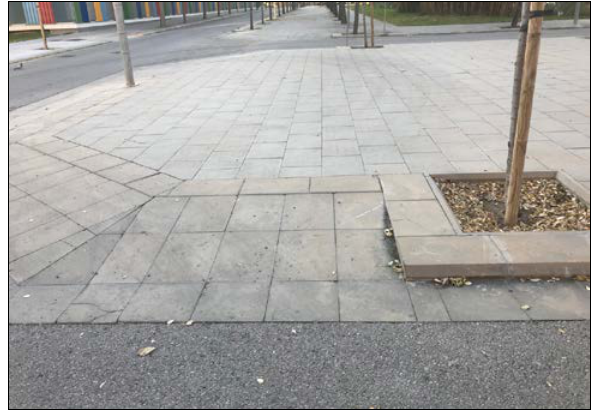
Figure 5. Curb ramp scenario.